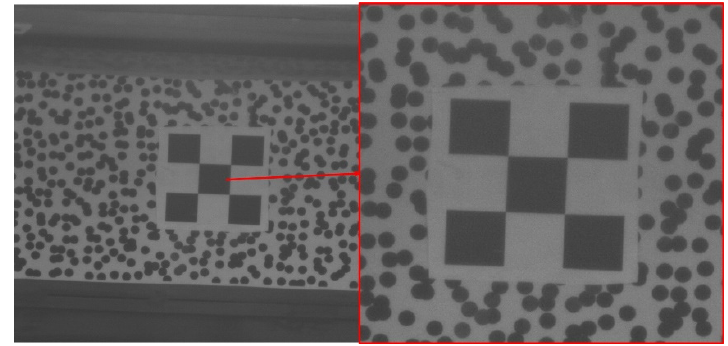
Figure 12. One of the experimental images.